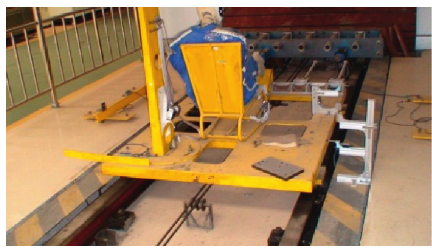
Figure 1: Test sled.